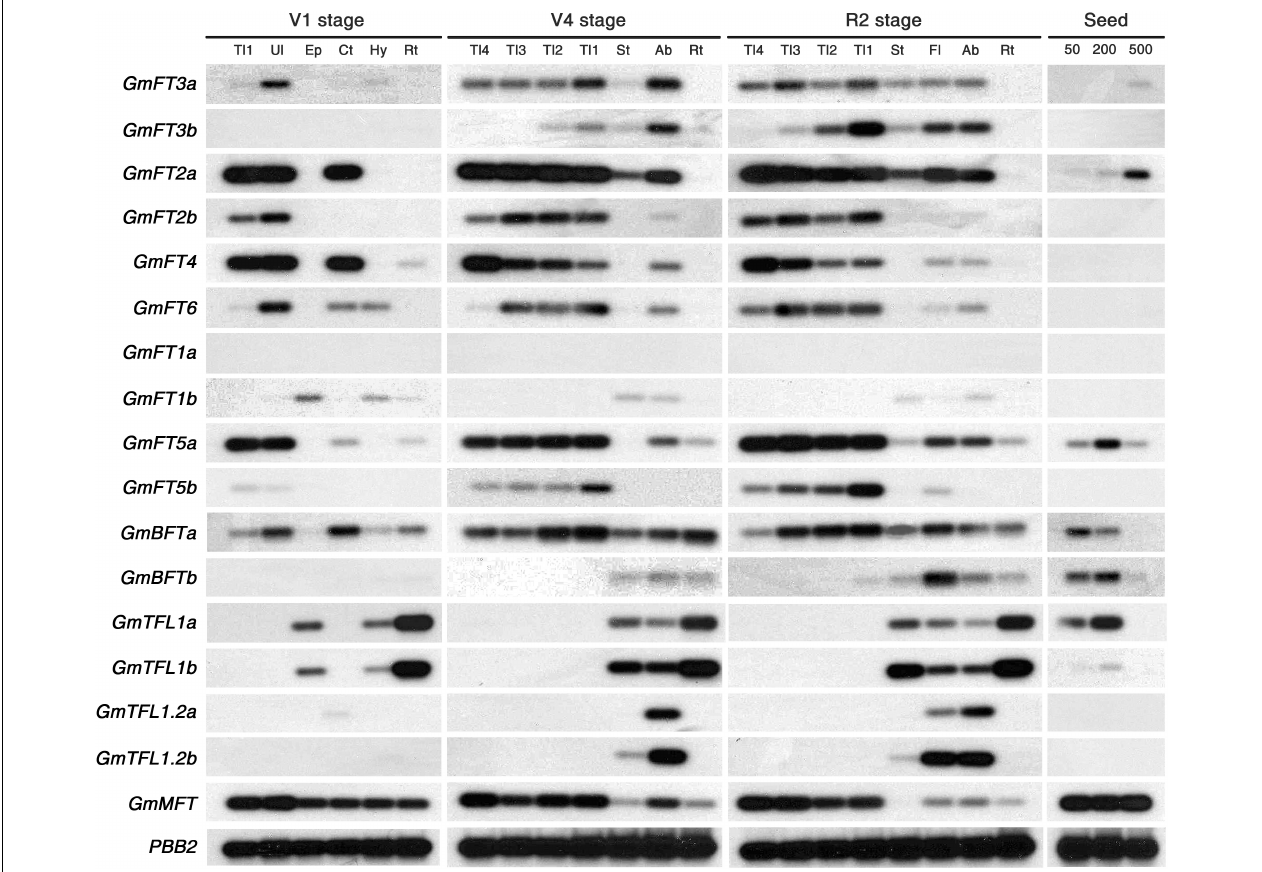
FIGURE 2 | Expression analysis of soybean PEBP family members. Total RNAs were extracted from various tissues at different developmental stages of soybean plants grown in natural green house conditions. Transcript levels were analyzed by RT-PCR and subsequent Southern blotting. Soybean PBB2 (20S proteasome beta subunit) mRNA (Glyma14g01850) was used as a control (Thakare et al., 2010). Tl: trifoliate leaf (Tl1; oldest, Tl4; youngest), Ul: unifoliate leaf, Ep: epicotyl, Ct: cotyledon, Hy: hypocotyl, Rt: root, St: stem, Ab: axillary bud, Fl: flower. Seed weights of 50, 200, and 500 mg are weights of single